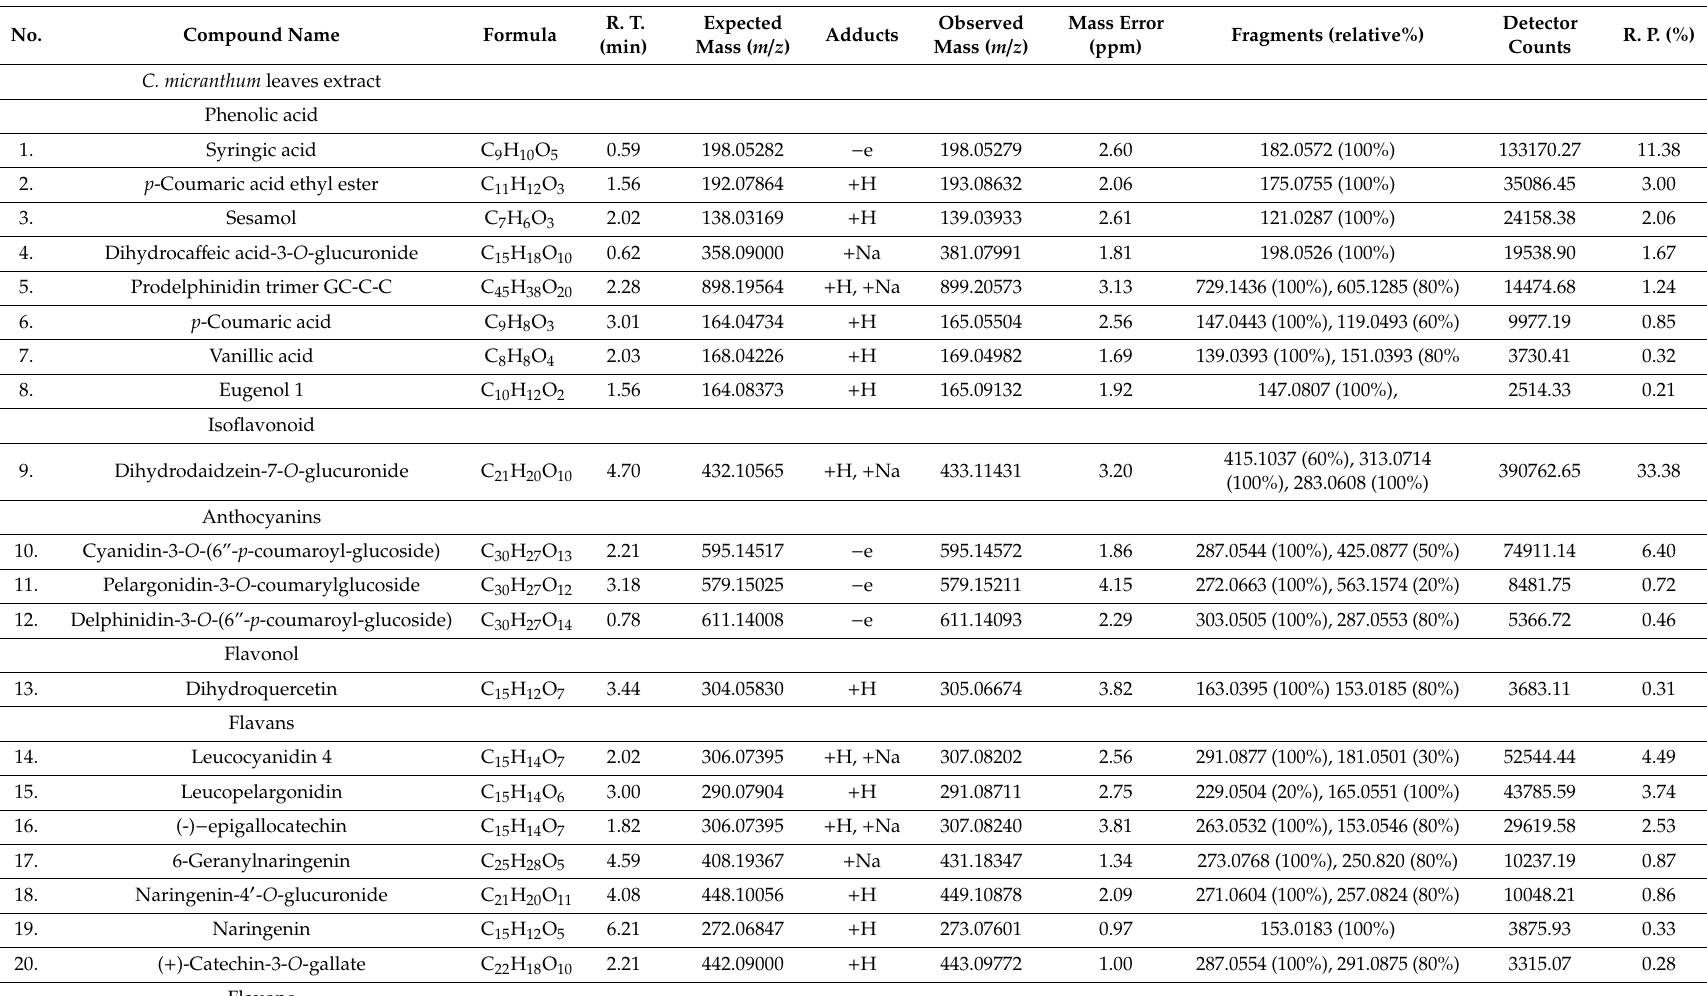
Table 3. Identification of phenolic compounds and other phytochemicals by high-resolution LC-MS (R. T.: Retention time; R. P.: Relative